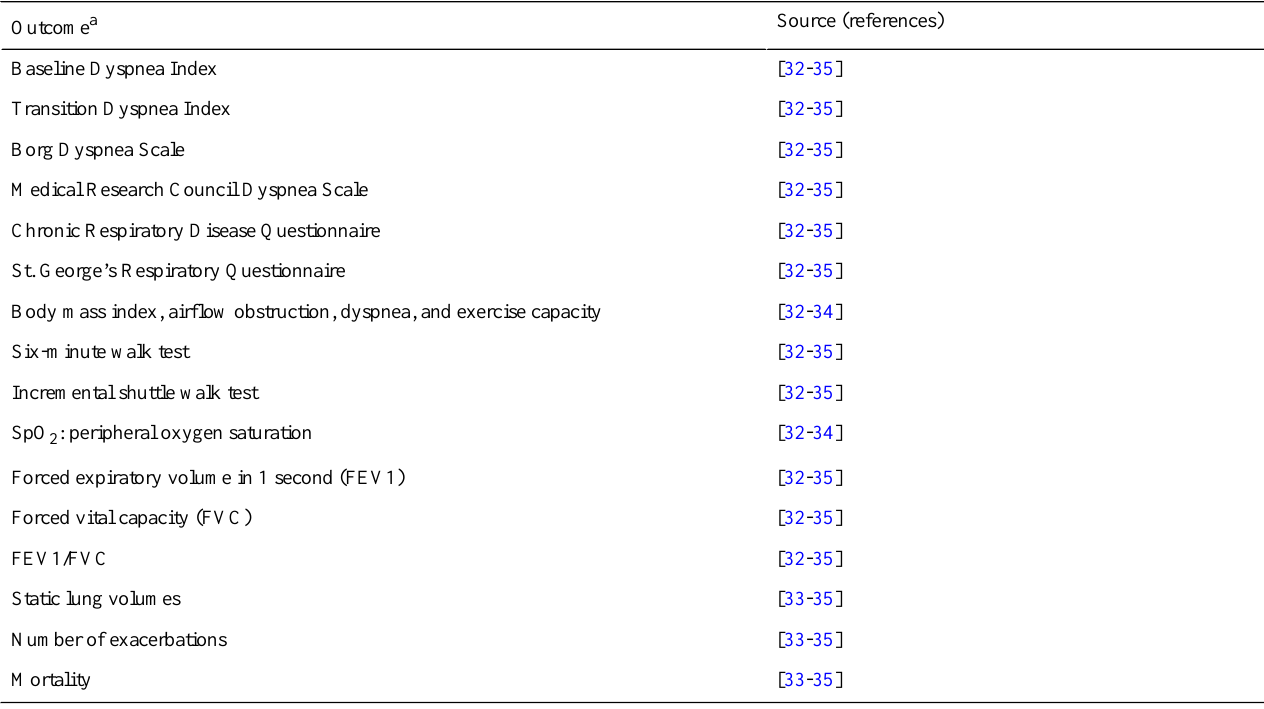
Table 4. Top outcomes abstracted from published